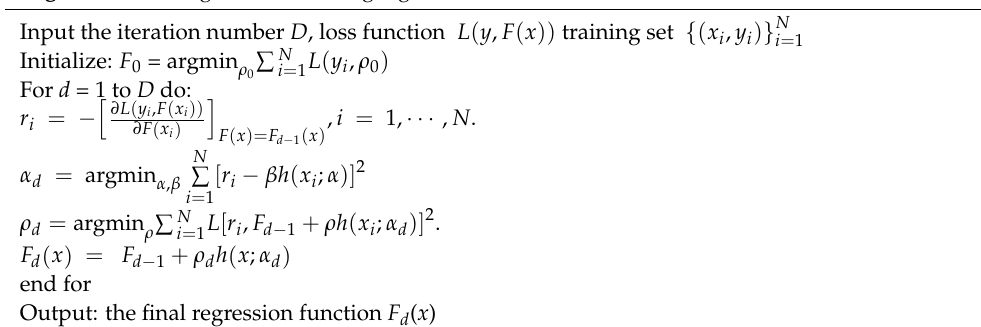
Algorithm 1. The gradient boosting